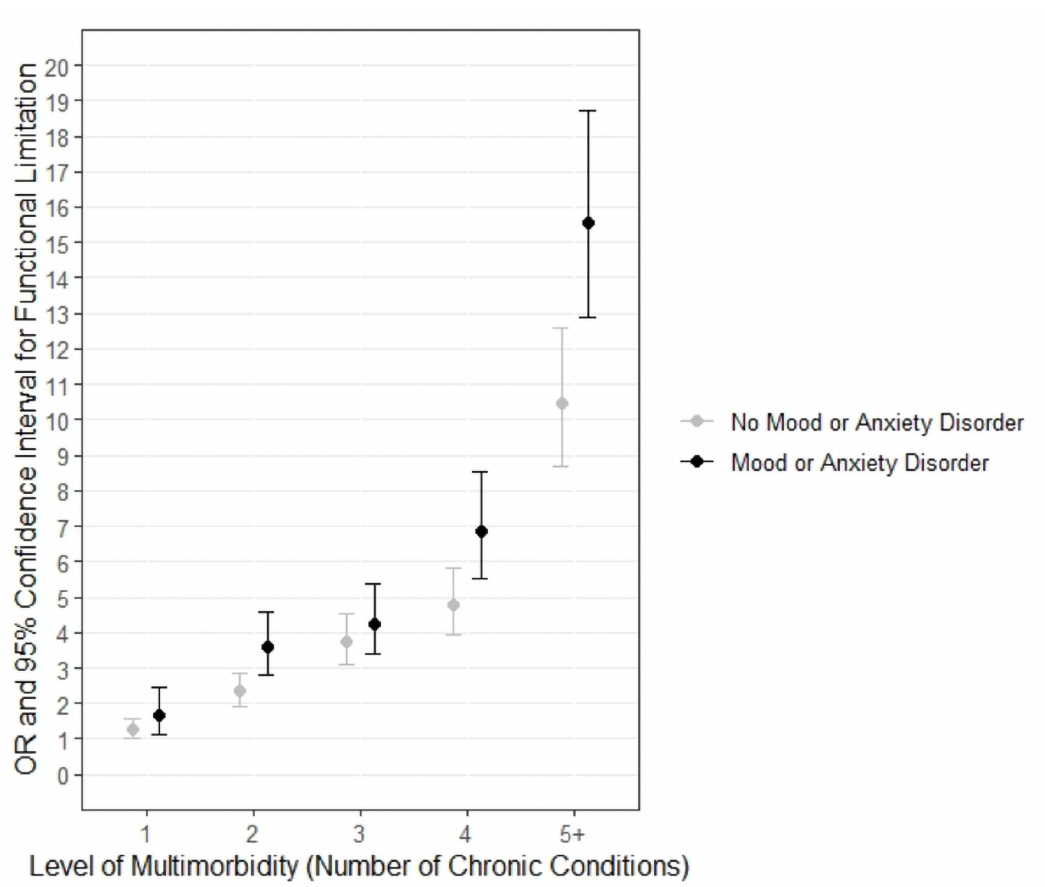
Fig 3. Odds of functional limitation by multimorbidity and presence of mood/anxiety disorders (reference category—0 chronic conditions, models adjusted for age, sex, education).